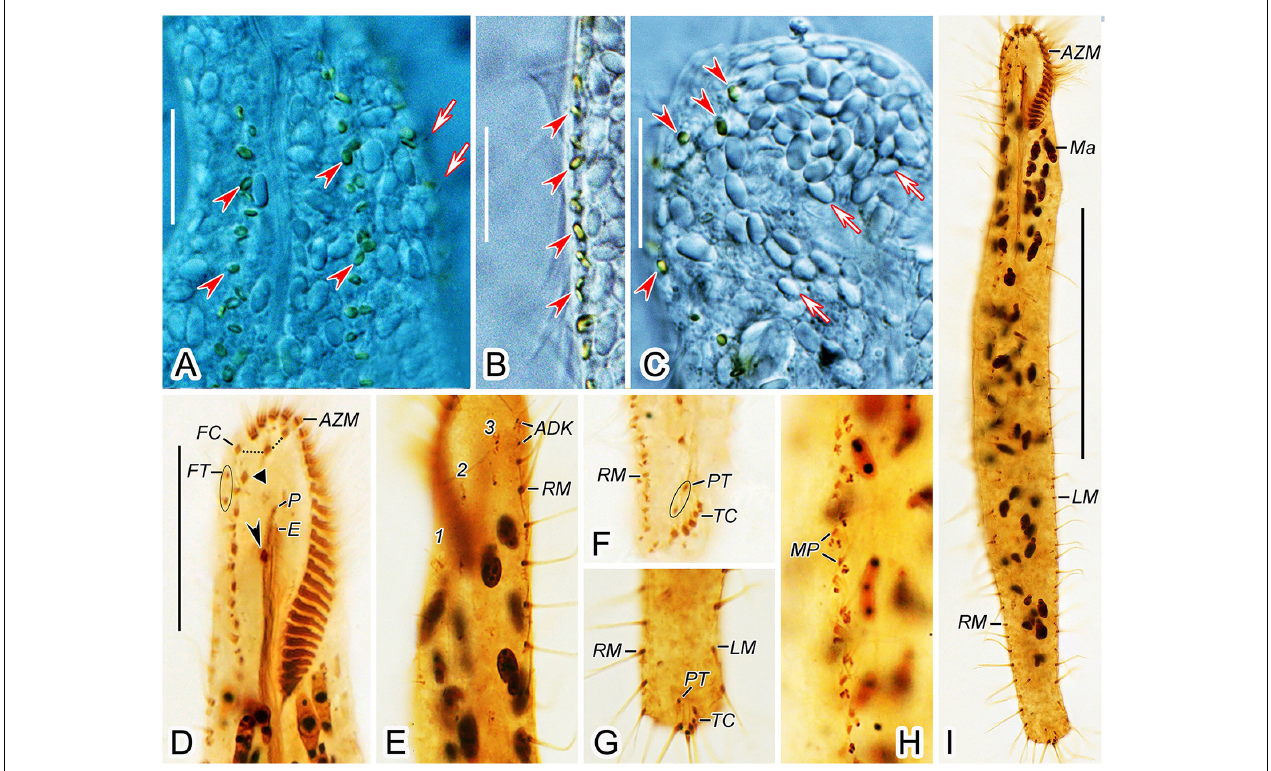
FIGURE 5 | Anteholosticha perezuzae sp. nov. from life (A–C) and after protargol impregnation (D–I) . (A–C) Ventral (A,B) and dorsal (C) views of the surface; arrowheads mark cortical granules. Arrows in (A) represent dorsal cilia and arrows in (C) point probable mitochondria. (D,E) Ventral (D) and dorsal (E) views of the anterior body regions; arrowhead shows the buccal cirrus, black triangle indicates the parabuccal cirrus. (F,G) Ventral views of the posterior body region, showing marginal cirral rows, pretransverse cirri, and transverse cirri. (H) Midventral cirral pairs. (I) Ventral view of the holotype specimen. ADK, additional dorsal bristles at anterior end of the right marginal cirral row; AZM, adoral zone of membranelles; E, endoral membrane; FC, frontal cirri; FT, frontoterminal cirri; LM, left marginal cirral row; Ma, macronuclear nodules; MP, midventral cirral pairs; P, paroral membrane; PT, pretransverse cirri; RM, right marginal cirral row; TC, transverse cirri; 1–3, dorsal kineties 1–3. Scale bars = 10 µ m (A–C) , 25 µ m (D–H) , 100 µ m (I)